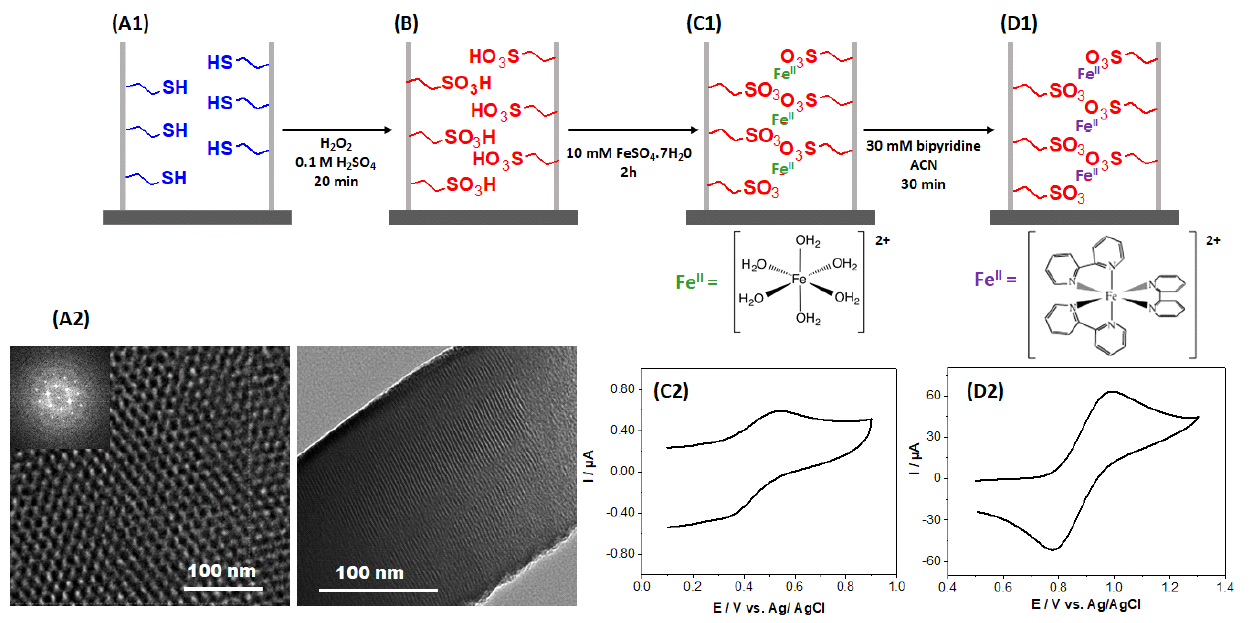
Figure 1. ( A ) Mercaptopropyl-functionalized silica thin films electrochemically obtained by EASA from TEOS and MPTMS as silane precursors (( A1 ): schematic illustration of one mesopore channel; ( A2 ): TEM top and cross-section views). ( B ) Chemical oxidation of the mercaptopropyl functions into propylsulfonate using a solution of hydrogen peroxide in 0.1 M H 2 SO 4 . ( C1 ) Immobilization of [Fe(H 2 O) 6 ] 2+ in sulfonated-functionalized silica films by immersion in an aqueous solution con- taining 10 mM FeSO 4 • 7H 2 O for 2 h in an inert atmosphere (( C1 ): illustrative scheme; ( C2 ): cyclic voltammogram recorded at a scan rate of 50 mV s − 1 in 0.1 M NaNO 3 aqueous solution). ( D ) Re- placement of the aquo ligands by immersion in an acetonitrile solution containing 30 mM bipyridine (( D1 ): illustrative scheme; ( D2 ): cyclic voltammogram recorded at a scan rate of 50 mV s − 1 in 0.1 M NaNO 3 aqueous solution).